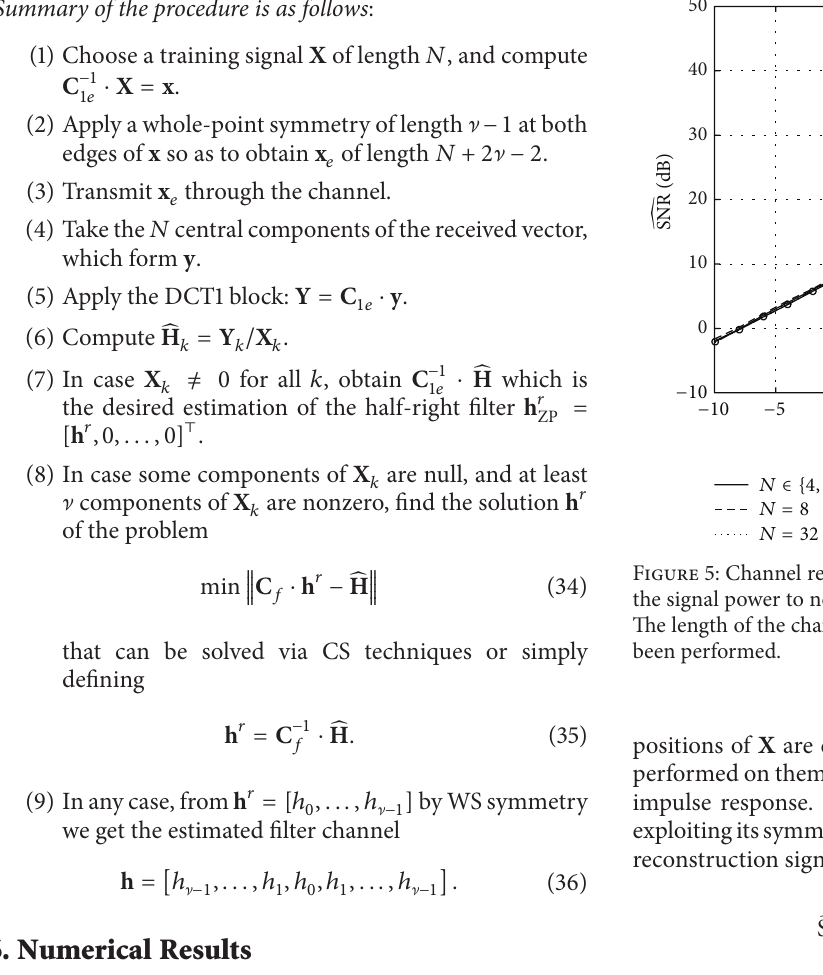
Figure 5: Channel reconstruction SNR ( the signal power to noise ratio (SNR ( dB ) ) for different values of 𝑁 . The length of the channel is 𝐿 = 7 and 𝑁 𝑠 = 2000 simulations have been